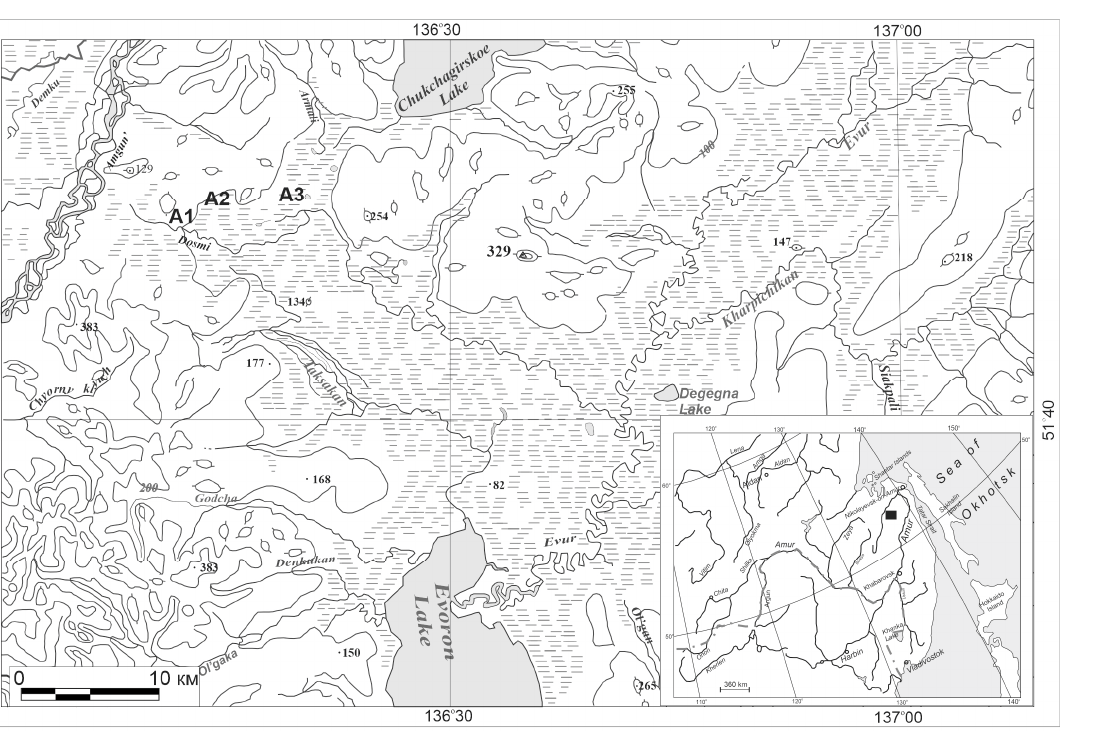
Figure 1. Study sites: A1–A3.